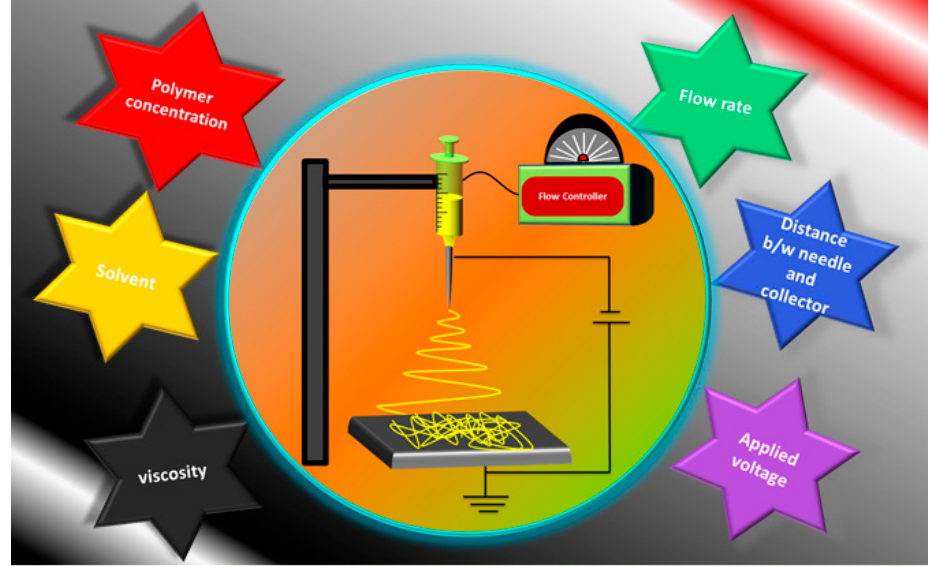
Scheme 1. Electrospinning set-up and the factors influencing the continuous nanofibrous membrane